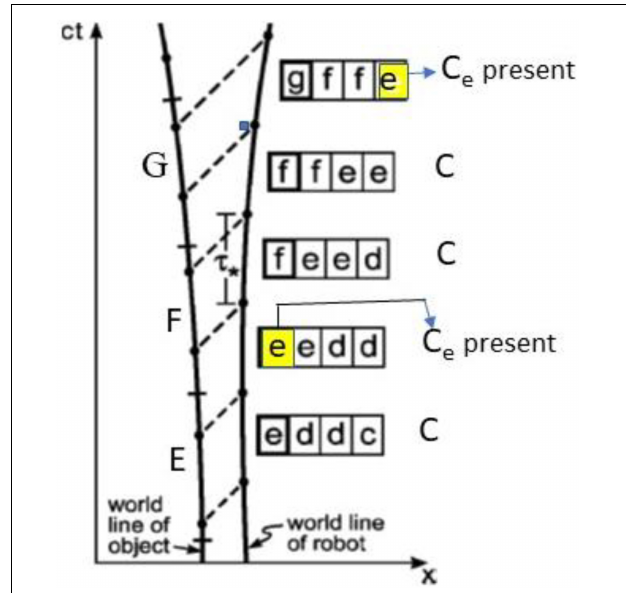
FIGURE 3 | A world-line description of the intermittently behind (IB)